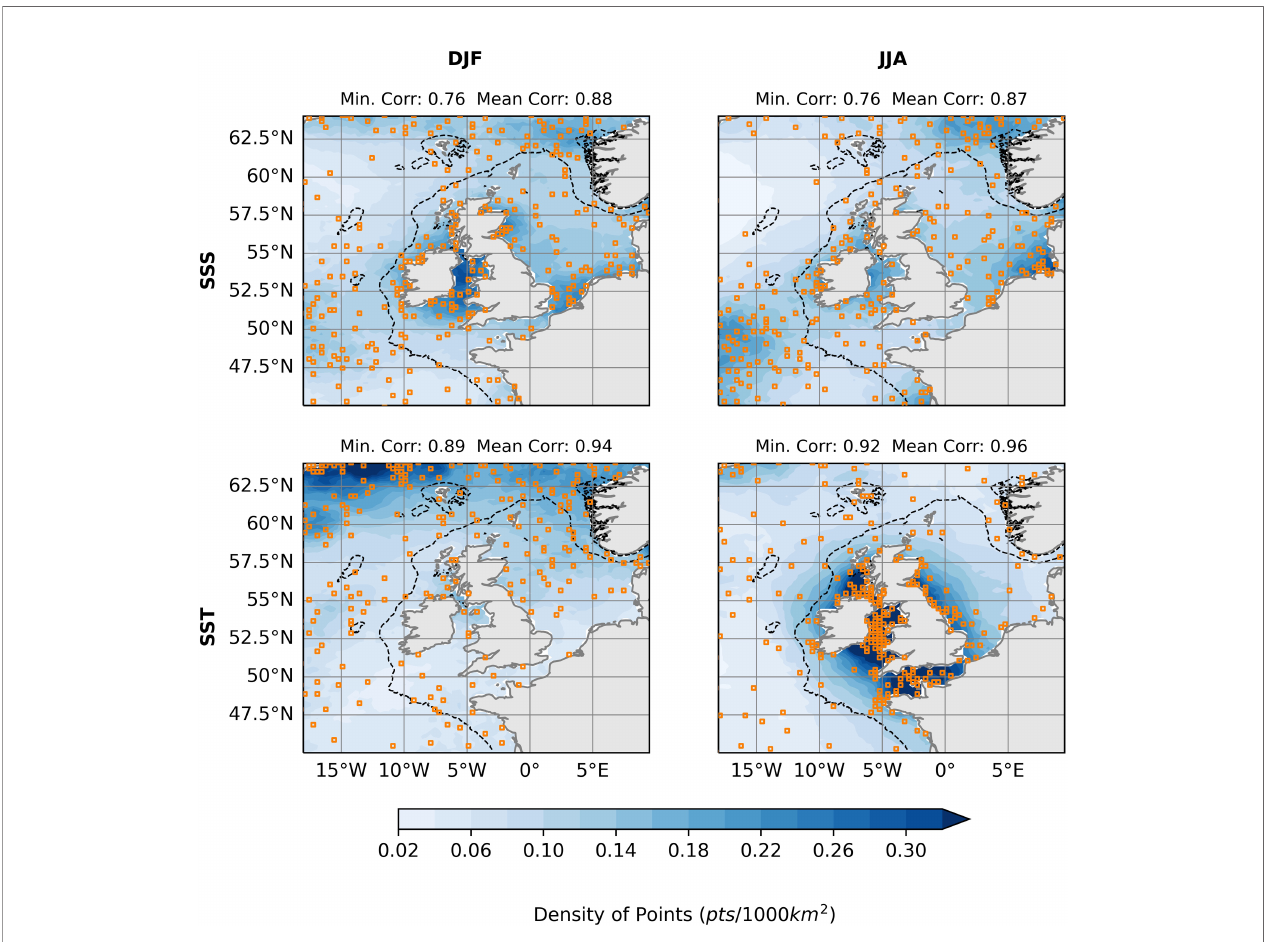
FIGURE 10 | MGSC observing networks for N=300. Top row shows results for sea surface salinity (SSS) and bottom shows sea surface temperature (SST). Results for two seasons are shown: Winter (DJF) in the left column and summer (JJA) in the right column. Blue shading shows an estimate of horizontal point